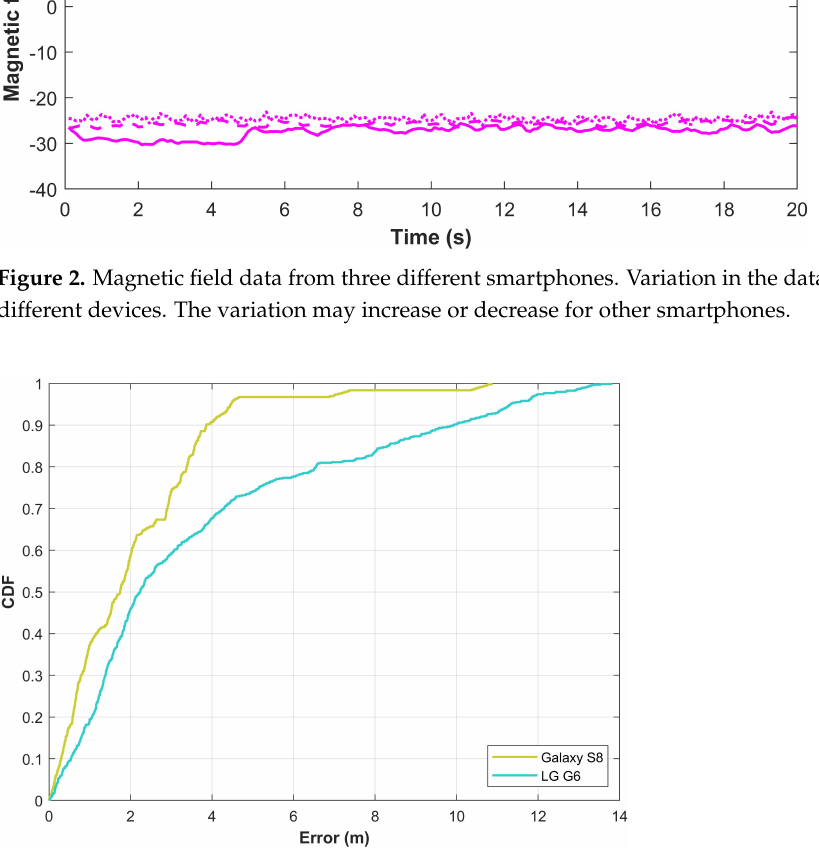
Figure 3. The CDF graph for magnetic field data based positioning using two different